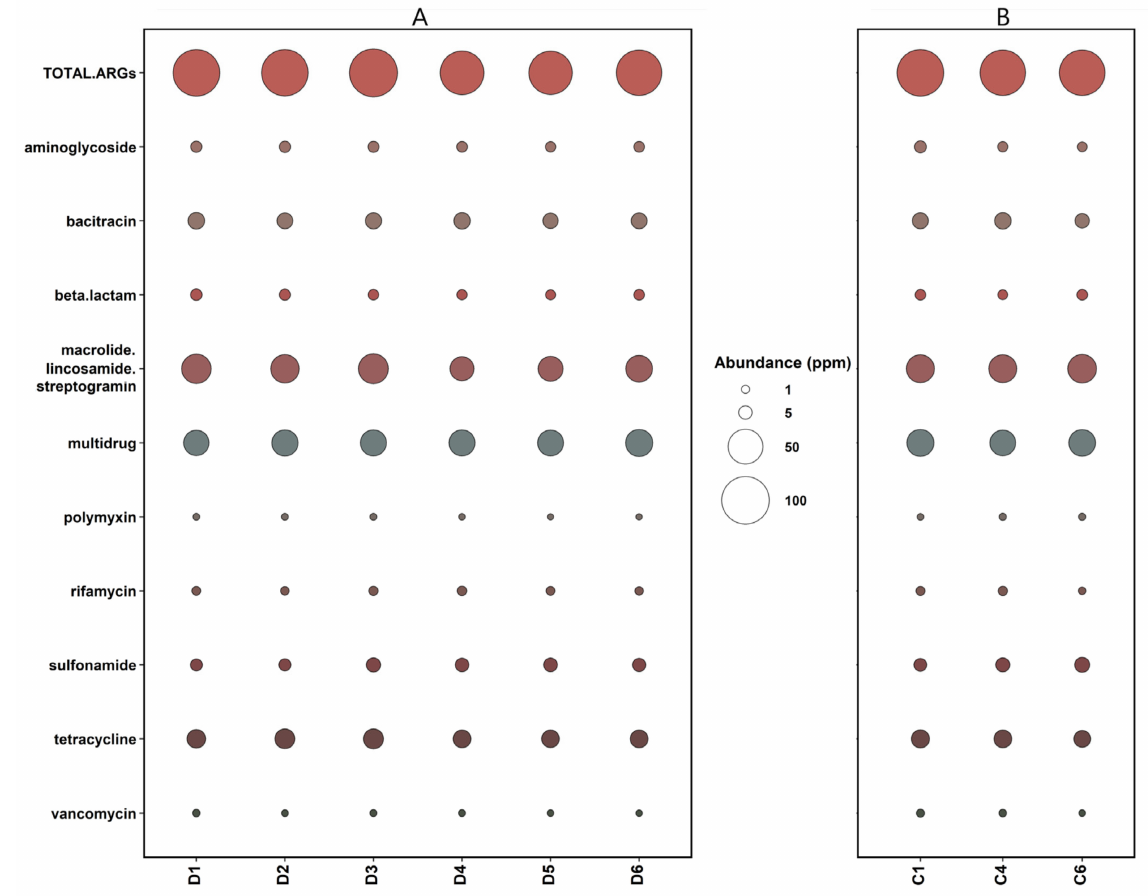
Figure 8. A bubble plot presenting changes in ARG abundance [ppm] in sewage sludge samples from process ( A ) and control bioreactors ( B ). The mean values noted in each experiment were used in the analysis. D-dose ID, C-control samples, ARGs-antibiotic resistance